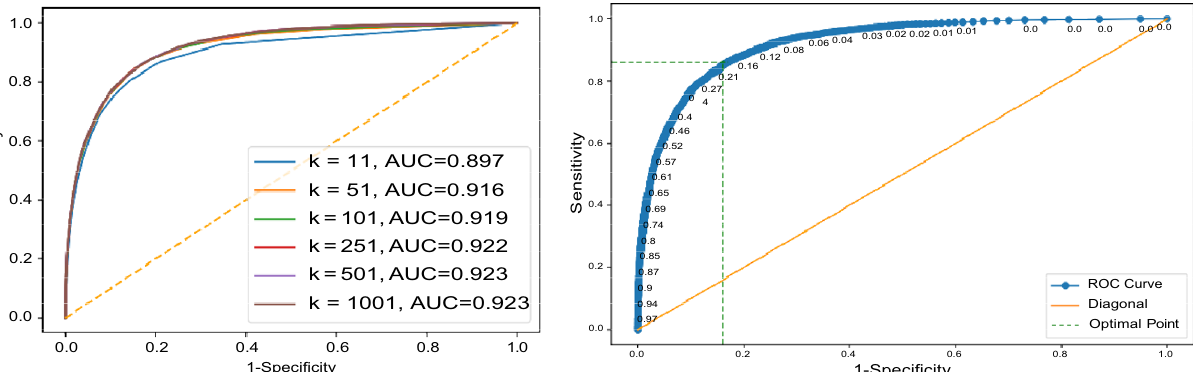
Figure 7. Analysis for Dataset 1. Left: Sample ROC curves for the proposed AutoThorax -Net for different k values in one fold and their area under the curve (AUC), Right: corresponding ROC thresholds for k = 1001 to select the sensitivity–specificity trade-off using Youden’s